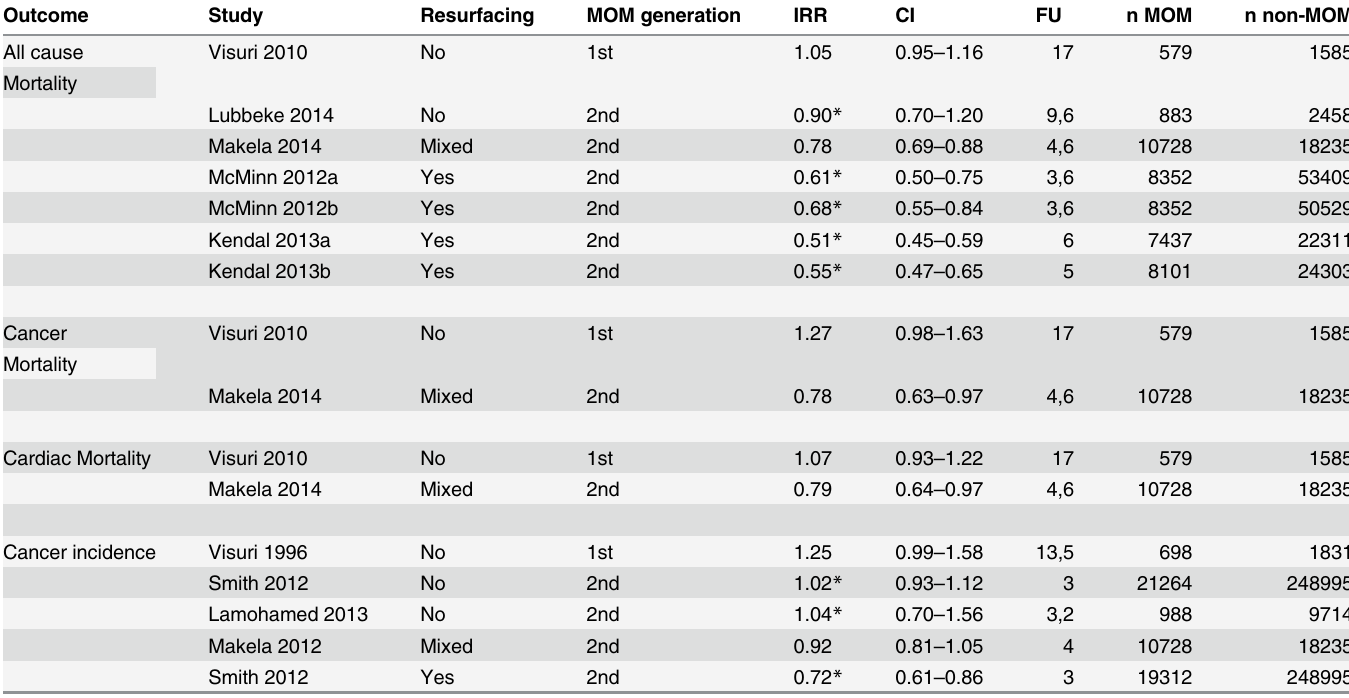
Table 2. Results from observational